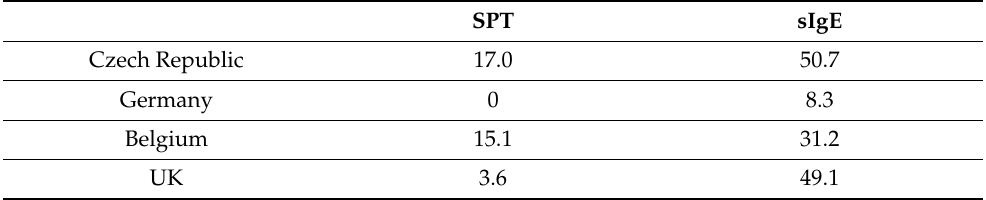
Table 11. Diagnostic actions requested stratified by country